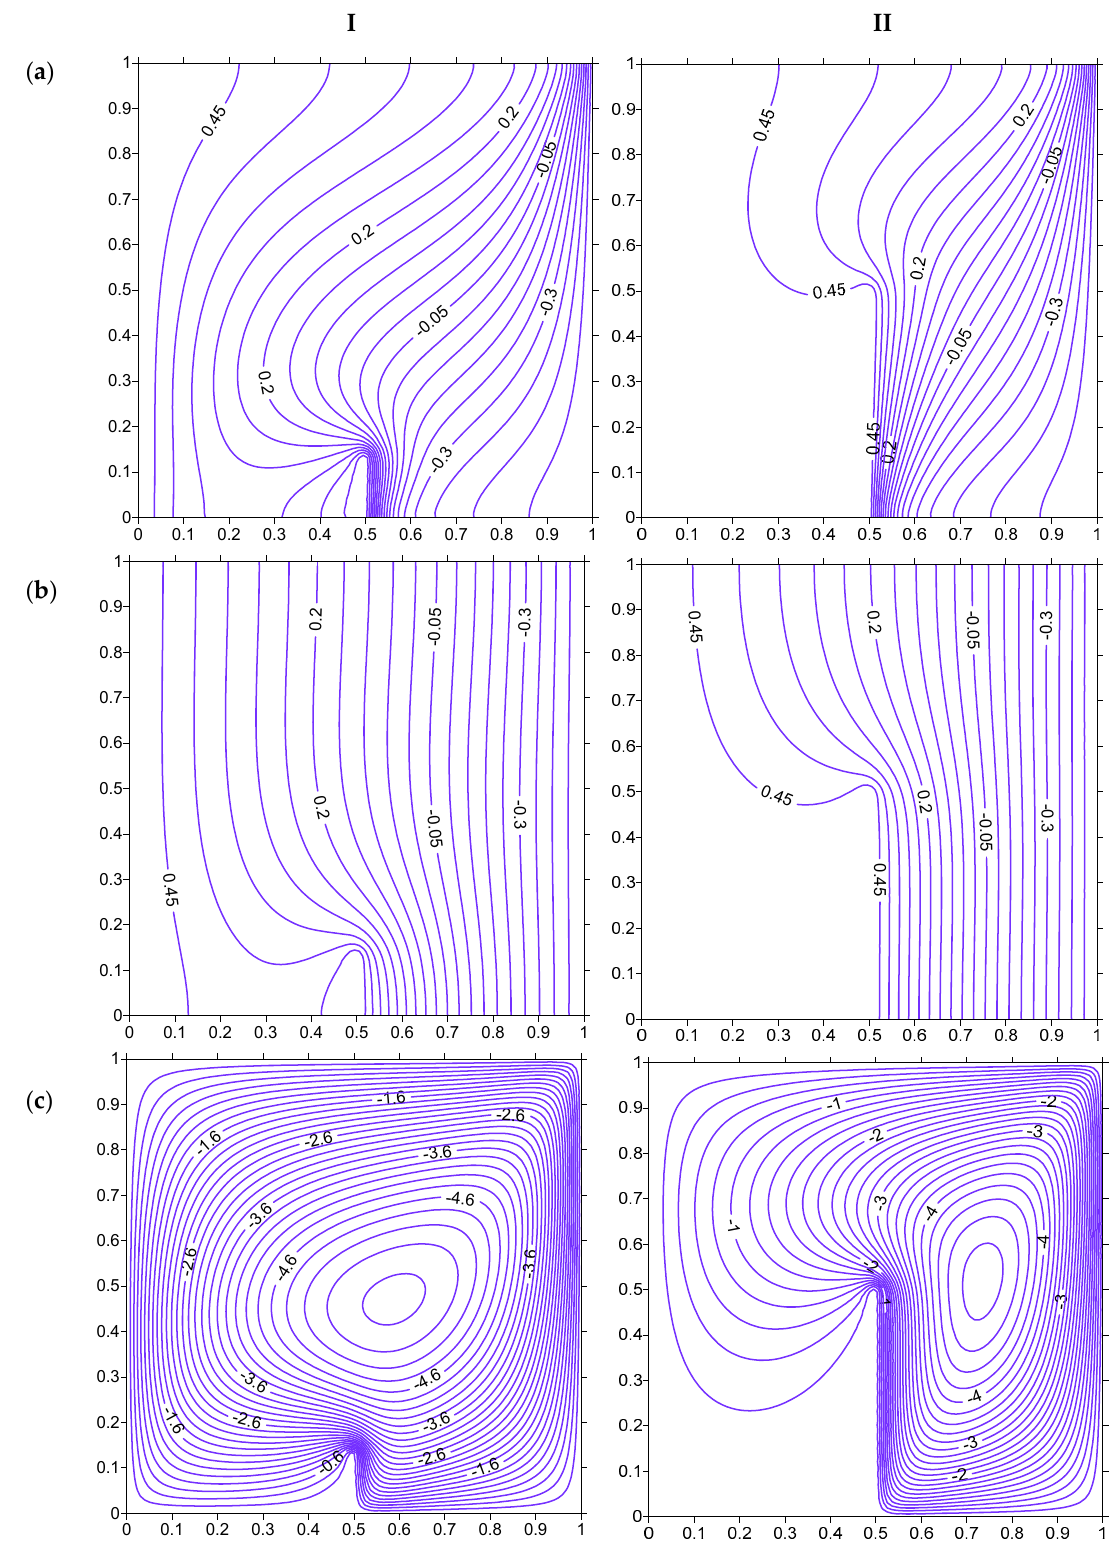
Figure 19. Isotherms (( a ) Fluid, ( b ) Solid), and streamlines ( c ), at Ra = 100, H = 5, Kr = 1, Rd = 0 for strip at x = 0.5. ( I ) HH = 12.5%. ( II ) HH =